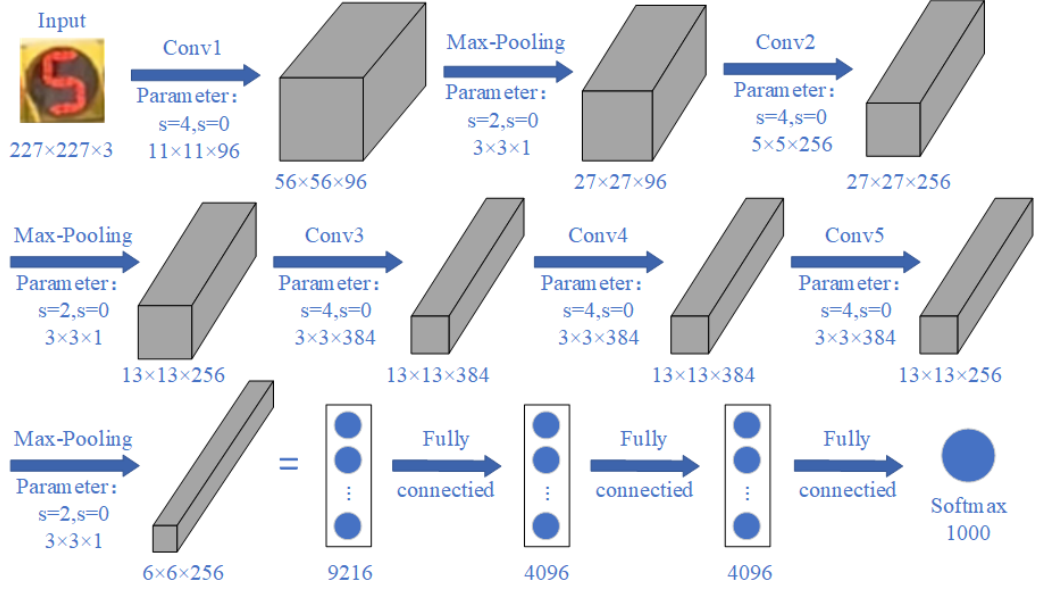
Figure 4. AlexNet network structure.